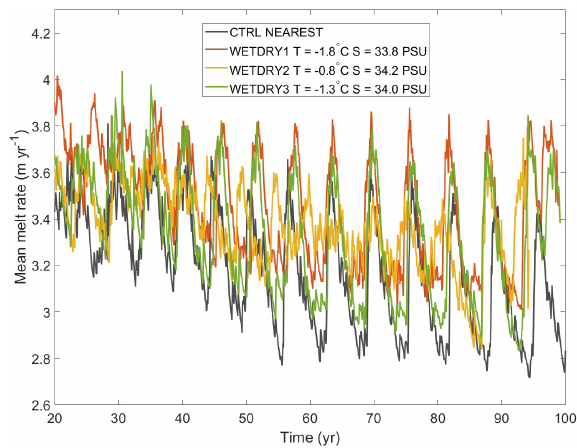
Figure 10. Simulated mean melt rates with different tracer proper- ties for the nudging dry